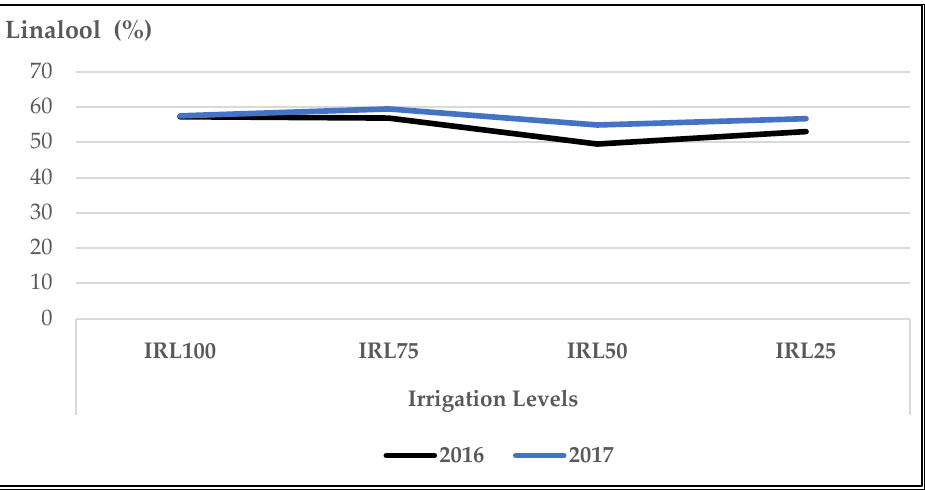
Figure 2. Mean values of 1,8-cineole (%) at di ff erent IRLs of O. basilicum L. essential oil; IRL 100 = 100% FC; IRL 75 = 75% FC; IRL 50 = 50% FC; IRL 25 = 25% FC without SM. The mean values of 1,8-cineole at IRL 100 (3.8% and 3.9%) were higher compared to IRL 25 (2.6% and 2.7%) in 2016 and 2017, respectively (Figure 2). OMH is included alongside linalool, camphor, and 1,8-cineole. The total amount of OMH was higher in the second year compared to the fi rst year. The mean values at IRL 100 and IRL 75 were higher than IRL 50 and IRL 25 (Figure 3).